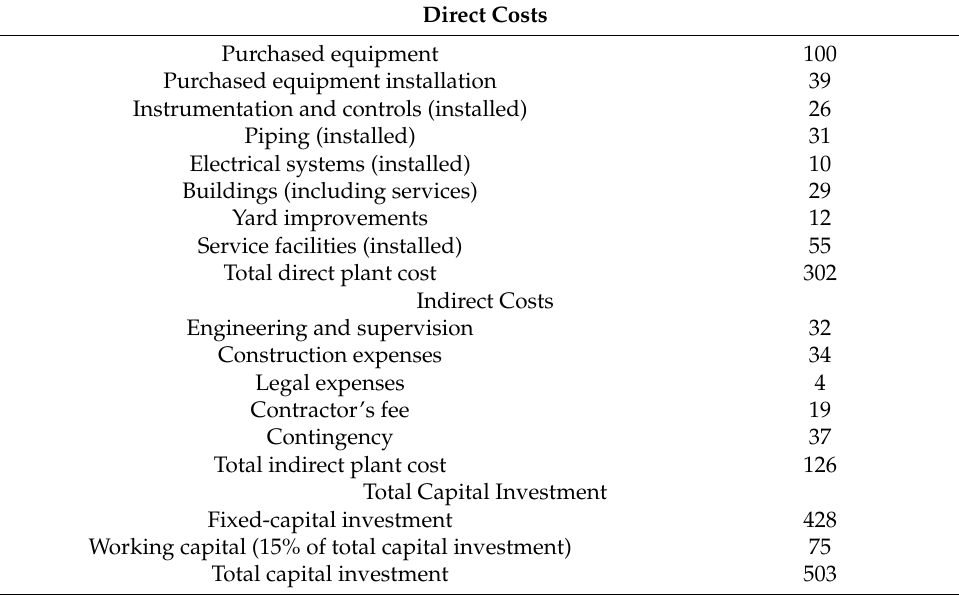
Table 2. Factors for total capital investment